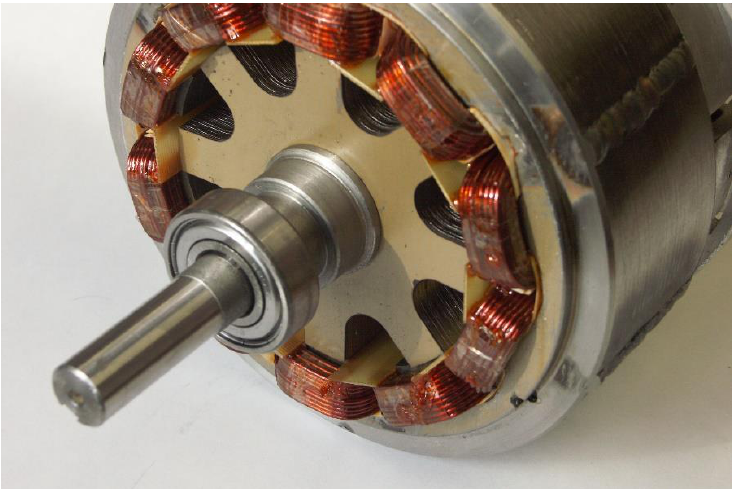
Figure 25. Tested 10/8 SRM motor during laboratory measurements.